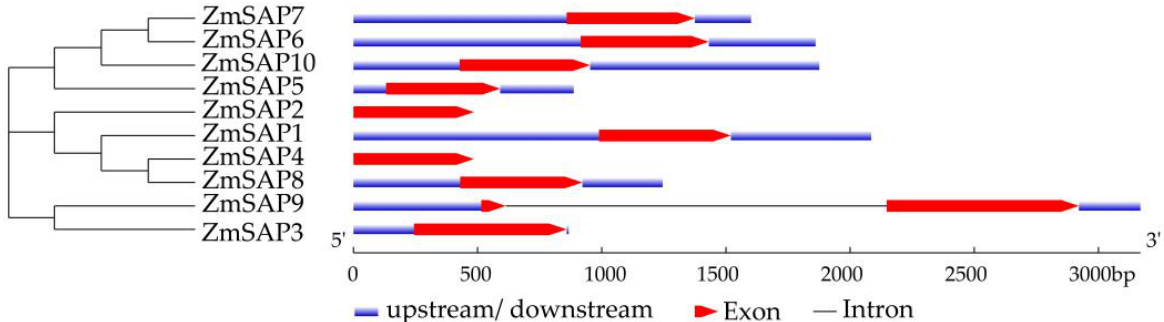
Figure 4. Gene structure of ZmSAPs . The red triangles indicate exons, and the blue boxes indicate 5’ or 3’ UTR, and the black line connecting exons indicates an intron.